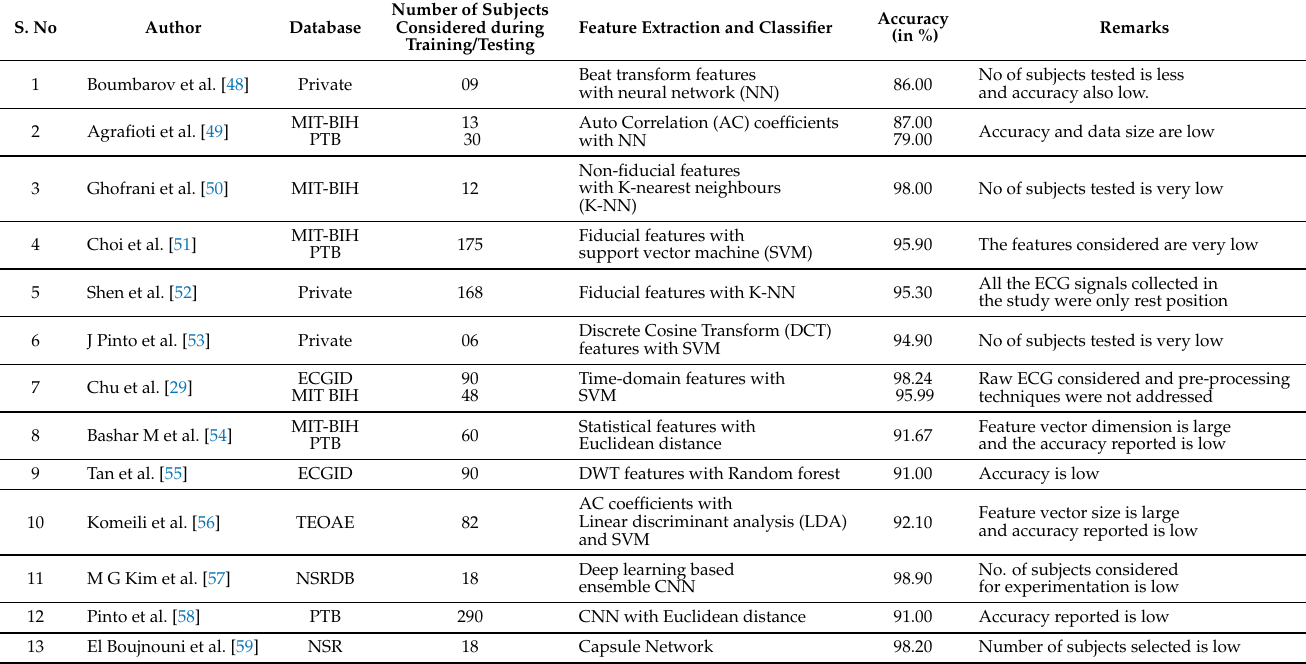
Table 1. The detailed literature for biometric authentication using ECG